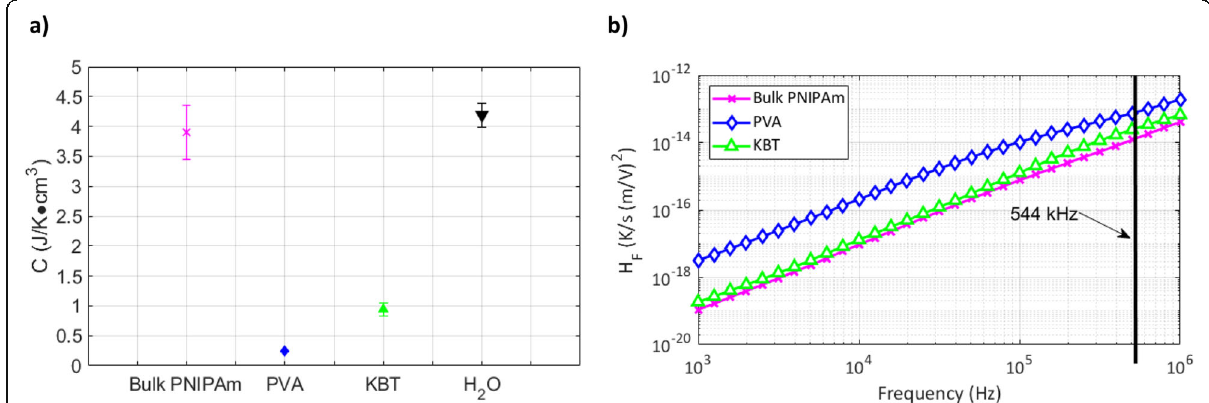
Fig. 5 Specific heat and RF heat factor. a Volume-specific heat capacity (C) for bulk PNIPAm, PVA-PNIPAm hydrogel, KBT hydrogel, and water derived from measured specific heat and volume for each sample. (left) The addition of PVA to the monomer solution in the free-radical polymerization process lowered the specific heat from nearly 4.0 J/(g ∙ K) in PNIPAm to 0.25 J/(g ∙ K) in PVA and 0.95 J/(g ∙ K) in KBT. b The heat factor (Hf). Equation 2 sans Ea with all the measured dielectric and material parameters. 544 kHz is the RF actuation frequency in this work (right)